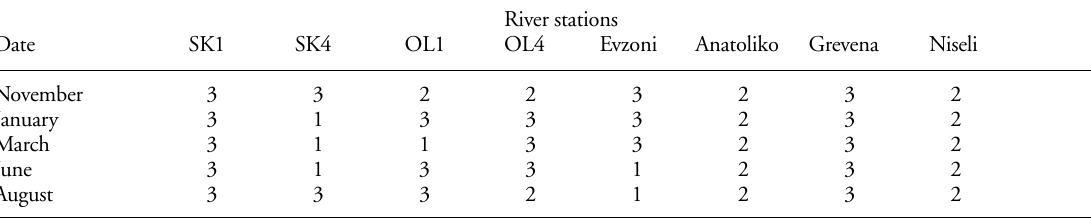
Table 3. Substrate categories (1: >70% bolders, cobbles pebbles, 2: >70% gravel, sand and silt, 3: equally represented) of Evzoni and Anatoliko at Axios river, Grevena and Niseli at Aliakmon river, two sites from Olympias area (OL1 and OL4) and Piavitsa (SK1) – Asprolakka (SK4) streams at Skouries area. River stations Date